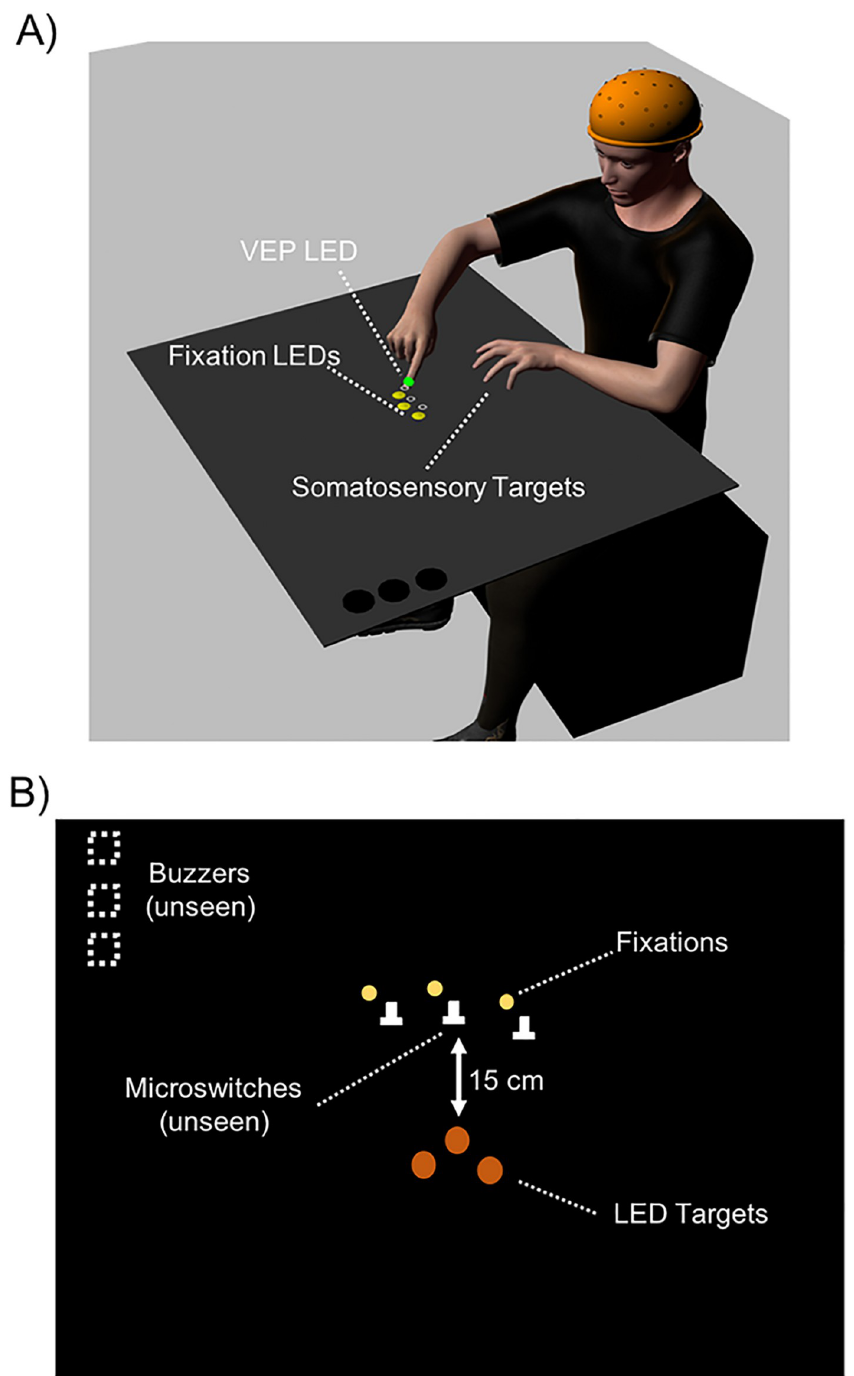
Fig 3. A) A depiction of the experimental apparatus used in Experiment 2 (not to scale). Participants fixated on one of three fixation locations and began their movements from the associated home position. As in Experiment 1, in both the AUD-VIS and AUD-SOMA conditions, piezoelectric buzzers indicated the targets and provided the imperative signal to initiate the reaching movement. In the AUD-SOMA condition, participants performed movements to either the index, middle, or ring finger of their non-reaching limb. In the AUD-VIS condition, participants performed movements to one of the three visual targets. B) A depiction of the aiming surface in the AUD-VIS condition (not to scale). There were three possible home positions such that the location of the task-irrelevant visual stimulus (the evoked potential stimulus) was in the same retinal location relative to the fixation position.